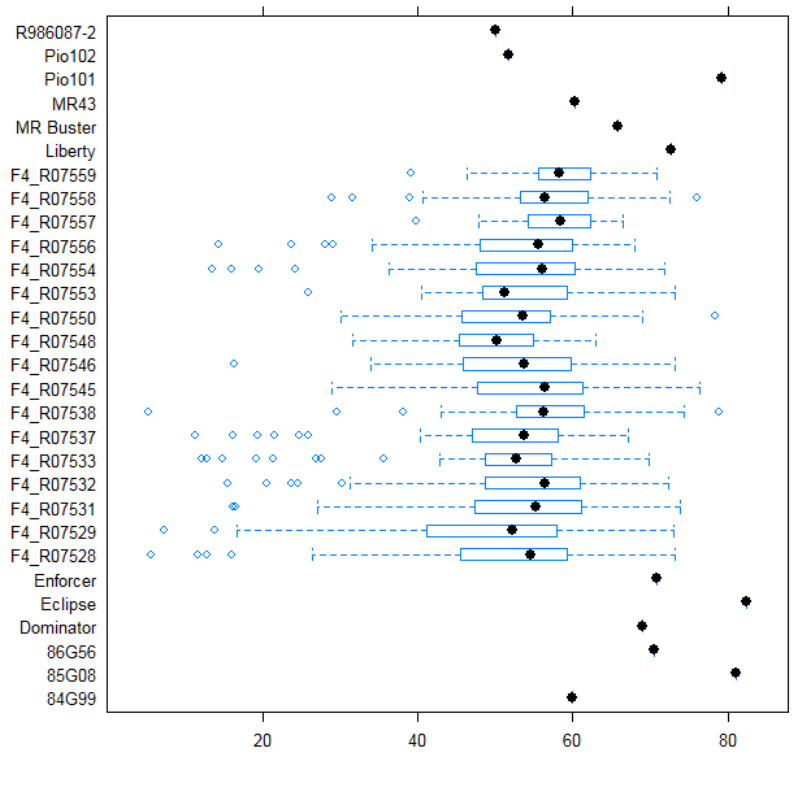
Figure 5. The boxplots of the best linear unbiased predictors (BLUPs) of green cover from a trial of commercial sorghum genotypes and of multiple hybrids produced from the F4 progeny of 17 families ( ca. 50 hybrids per F4 family), where the progeny were derived from separate crosses between R986087-2 and the 17 parental